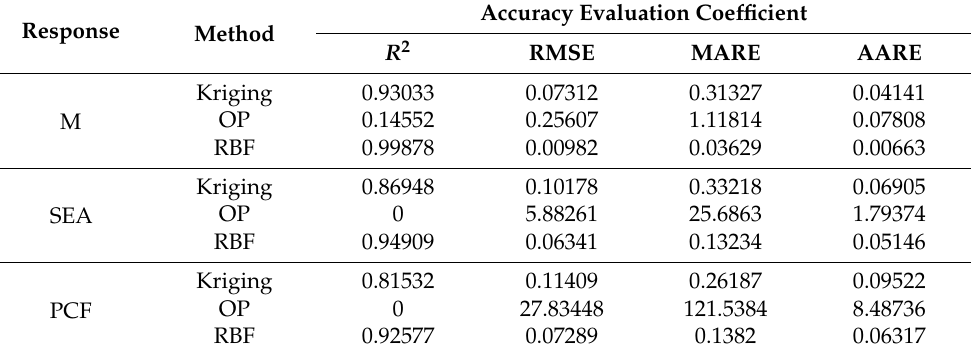
Table 7. Accuracy assessment of the surrogate